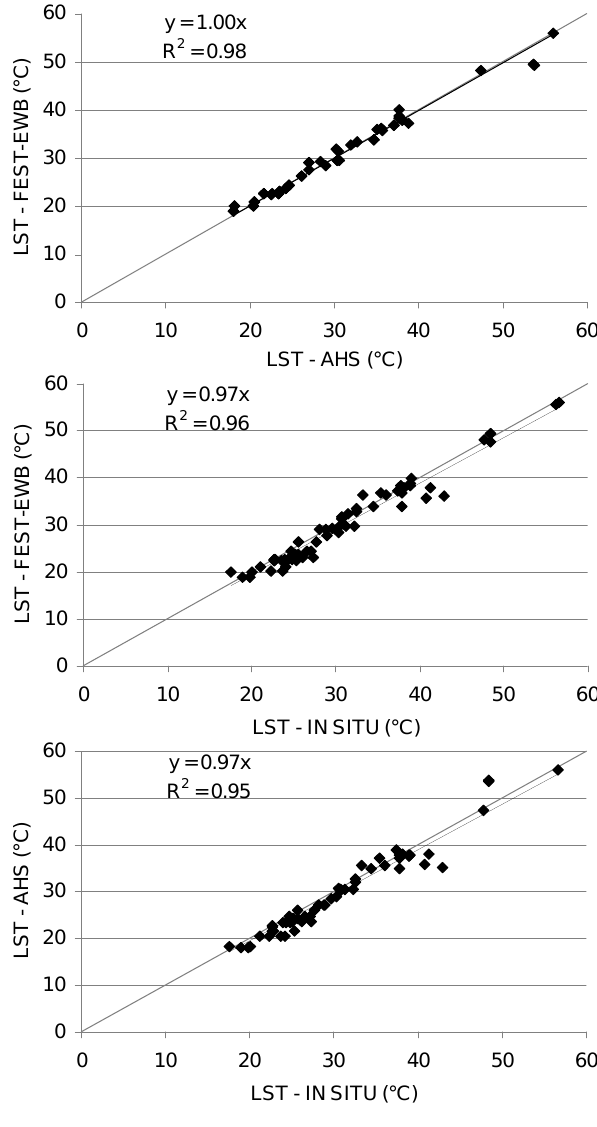
Fig. 3. Scatter plots between LST from AHS, FEST-EWB and in situ